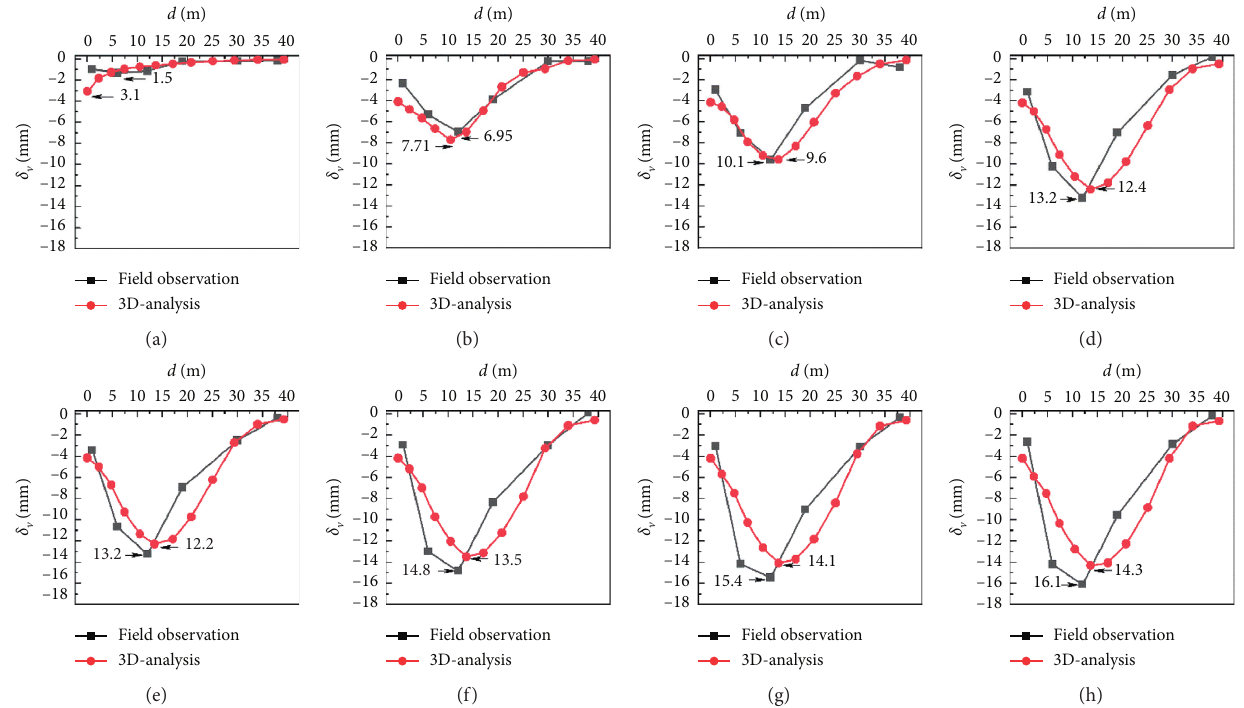
Figure 7: Surface settlement curve under various working conditions for YDM project. (a) Step 1, (b) step 2, (c) step 3, (d) step 4, (e) step 5, (f) step 6, (g) step 7, and (h) step 8.